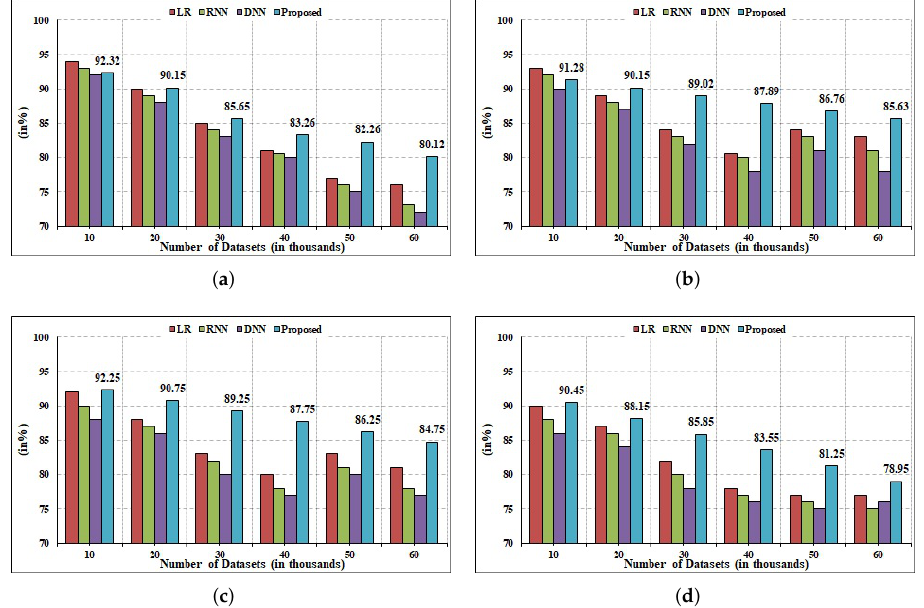
Figure 6. GRU-Model 2: Statistical Analysis. ( a ) Accuracy, ( b ) Precision, ( c ) Recall, ( d )